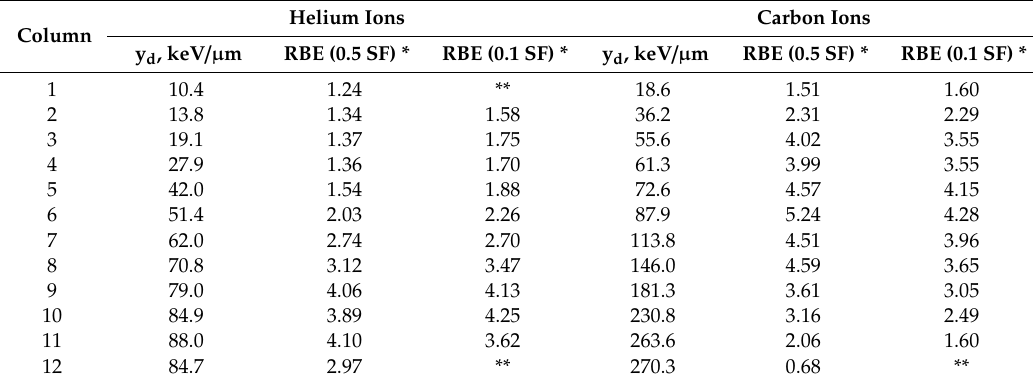
Table 1. Heavy ion RBE values for H460 cells.